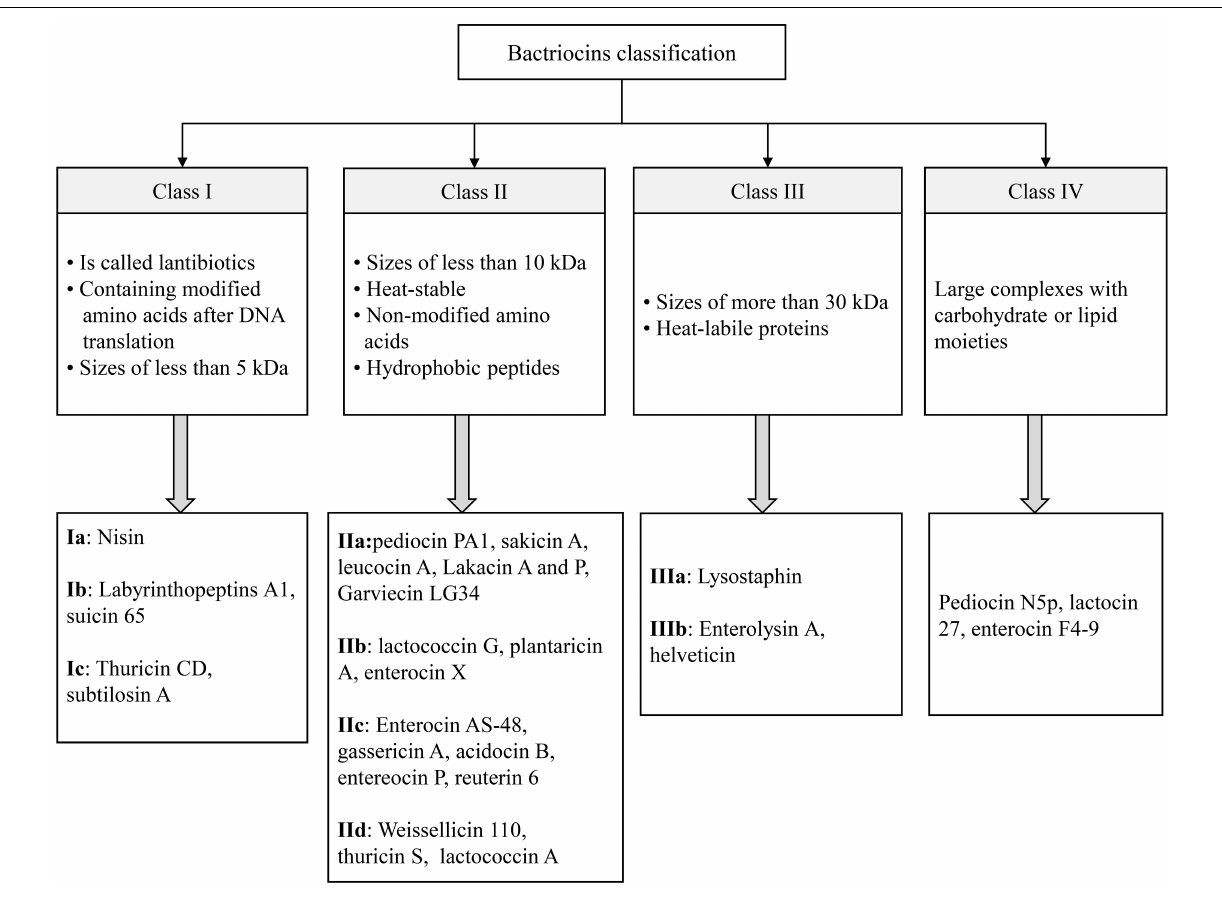
FIGURE 1 | The main classes and sub-classes of